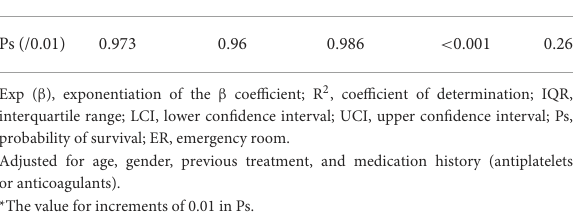
TABLE 4 Linear regression between serum SDC-1 and probability of survival in trauma patients at arrival at the ER. Factor Exp ( β ) * 95%LCI 95%UCI P -value R 2